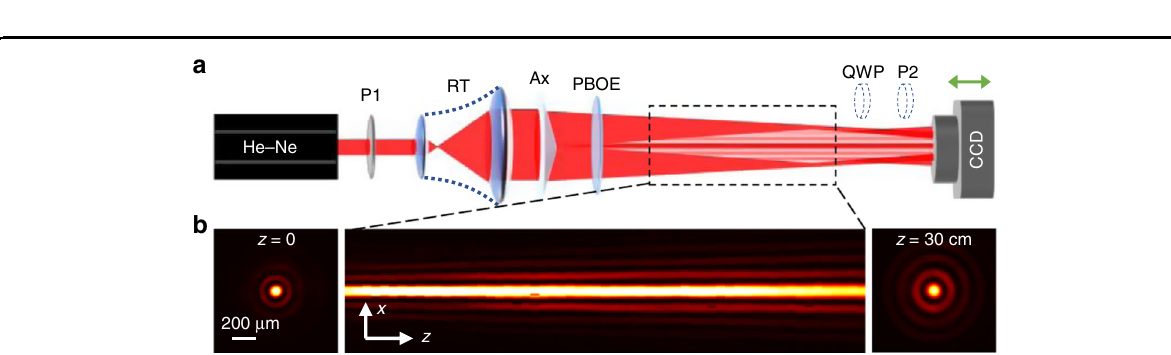
The corresponding polarizing micrographs are depicted by Fig. 2d, which manifest the optical axis orientation due to the birefringence of LC. The cyanic color of the micrograph is attributed to the corresponding wavelength meeting the half-wave condition. The optical axis dis- tributions of the LC elements are measured by the PB- phase method that we recently proposed 48,49 by illumi-